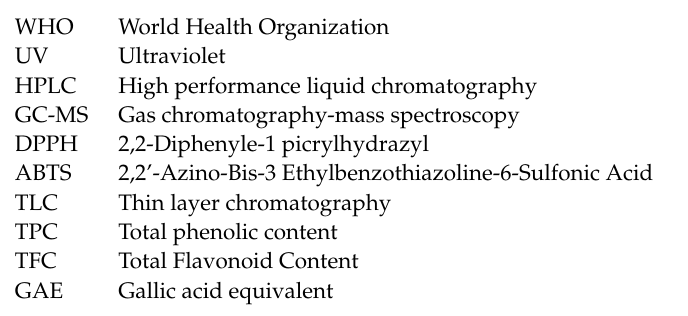
D of A. articulata . Figure S8. Individual mass fragmentation patterns of each compound: (A) Phenethyl alcohol, á -methyl (B) Benzyl-3-hydroxypyrrolidine (C) Diethyl Phthalate (D) 2,6-Dimethyl- pyridine-3,5-dicarboxylic acid, dihydrazide (E) Methoxycarbonyl-2-methoxyphenyl isothiocyanate (F) Phosphoric acid, dibutyl 3-trifluoromethyl-3-pentyl ester (G) Oleic Acid (H) 4-Acetylaminophthalic acid, dimethyl ester (I) Benzene-1,3-dicarboxylic acid (J) (2-Phenyl-1,3-dioxolan-4-yl) methyl (9E)-9- octadecenoate (K) 1-Heneicosyl formate (L) 18,19-Secoyohimban-19-oic acid (M) Cleavamine, 18 á - carboxy-3,4 à -dihydro-, methyl ester. Table S1. Major phytochemical compounds identified in fraction A of A. articulata and their various parameters. Table S2. Major phytochemical compounds and their parameters identified in fraction B of A. articulata . Table S3. List of major components and their parameters identified in fraction C of A. articulata . Table S4. Major phytochemical compounds and their parameters identified in fraction D of A. articulata. Table S5. Major phytochemical compounds and their parameters identified in the oil fraction of A. articulata. Table S6. Antibacterial potential of crude extract, oil, and purified fraction of A. articulata. Table S7. Antioxidant potential (DPPH and ABTS) of A. articulata crude extract, hexane, and subsequent fractions. Table S8. α -glucosidase and α -amylase inhibition of A. articulata crude extract and subsequent purified fractions at various